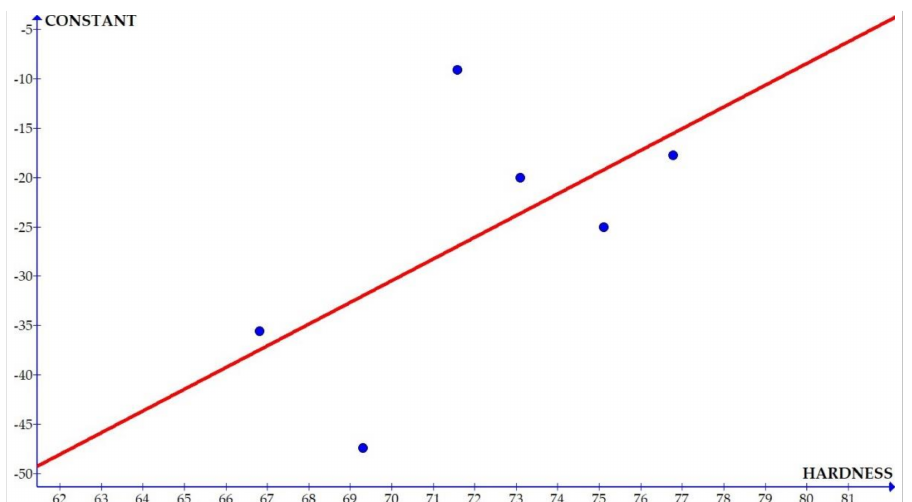
Figure 13. Coefficient of surface roughness: constant vs.